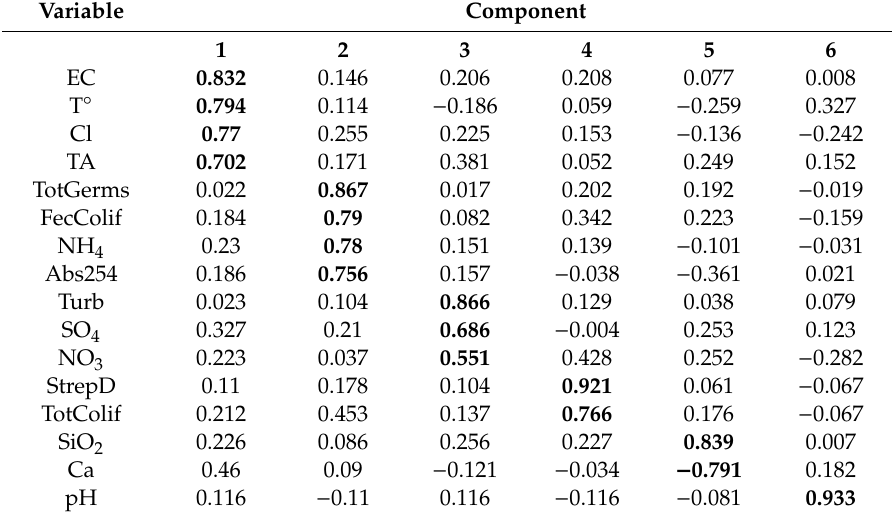
Table 4. Matrix of the first six components obtained for the PCA applied to the matrix including selected variables and sites, for the Kadisha-Abou Ali River, for two sampling campaigns (2003 and 2010).